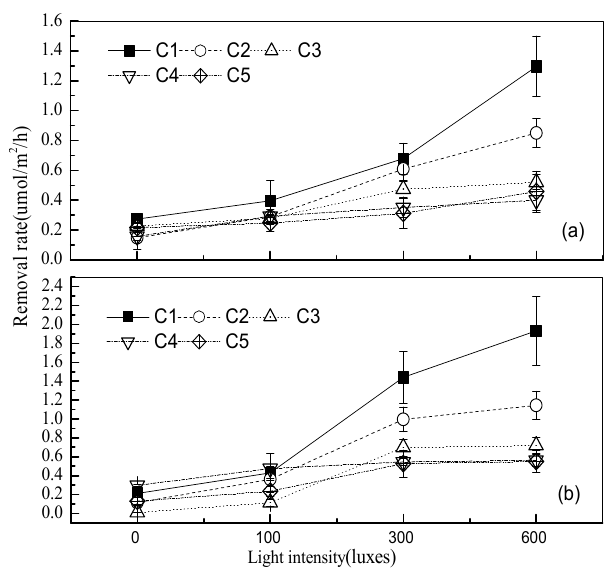
Figure 6. The removal rate of C 1 –C 5 aldehydes of Schefflera octophylla (Lour.) Harms ( a ) and Chamaedorea elegans (Lour.) Harms ( b ). C 1 : formaldehyde; C 2 : acetaldehyde; C 3 : propionaldehyde;